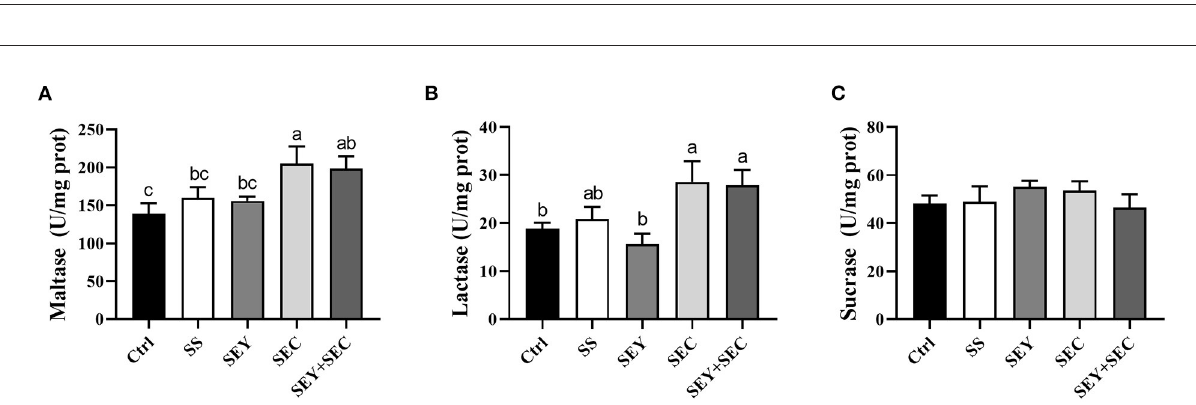
FIGURE2 Effects of different Se sources on the disaccharidase activities of jejunum in piglets. (A–C) The activity of maltase (A) , lactase (B) , and sucrase (C) in the jejunum. Values are means ± SEM, n = 6. a,b,c Means without a common letter differ, P < 0.05. Ctrl, control group; SS, sodium selenite; SEY, Se-enriched yeast, SEC, Se-enriched Cardamine violifolia ; SEY + SEC, Se-enriched yeast + Se-enriched Cardamine violifolia .